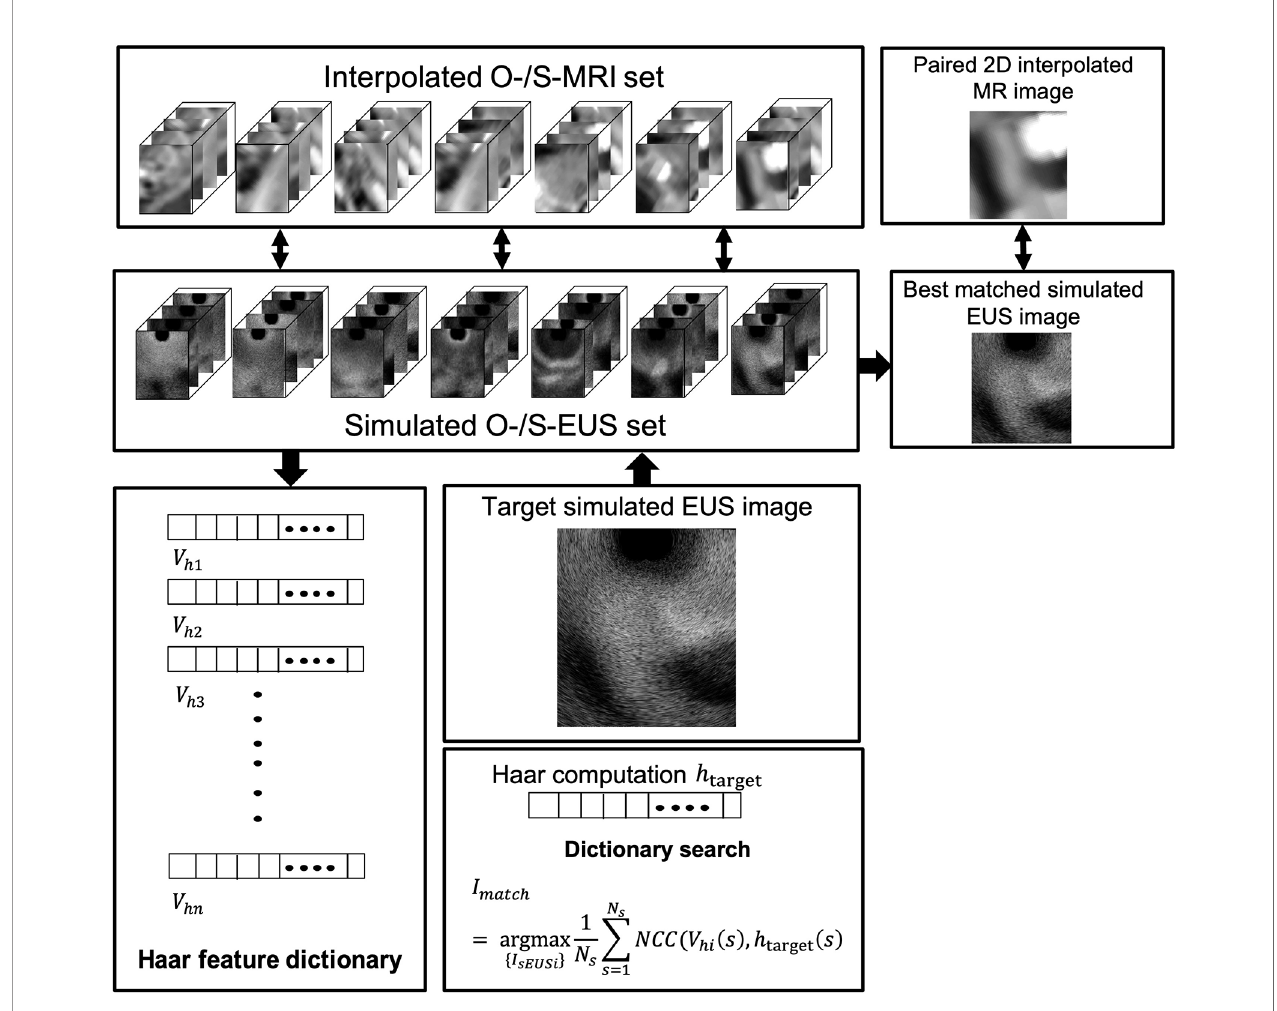
FIGURE 6 | The work fl ow of patient ’ s MRI